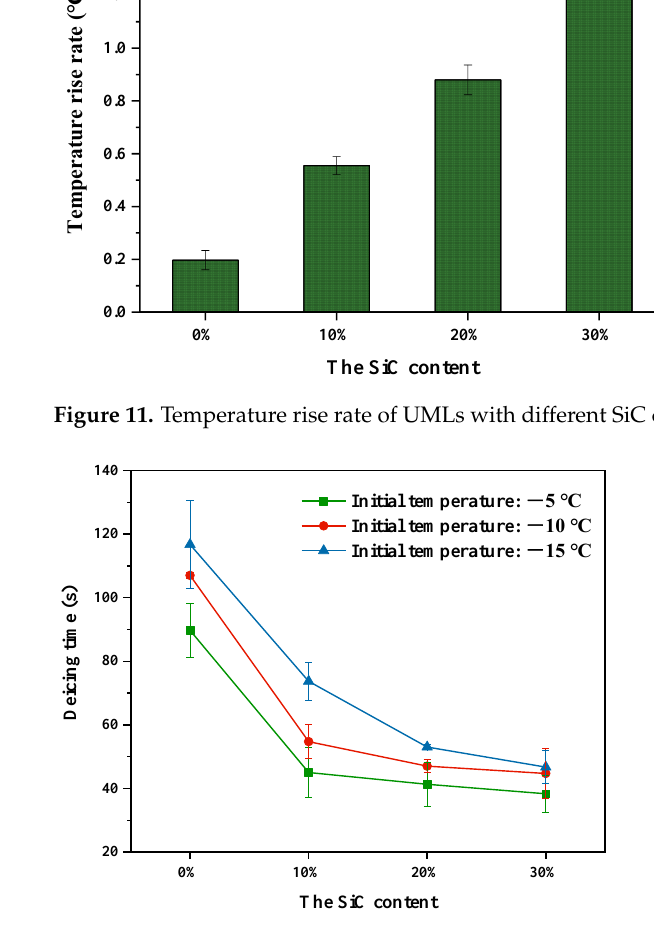
Figure 12. Deicing time of UMLs with different SiC contents.